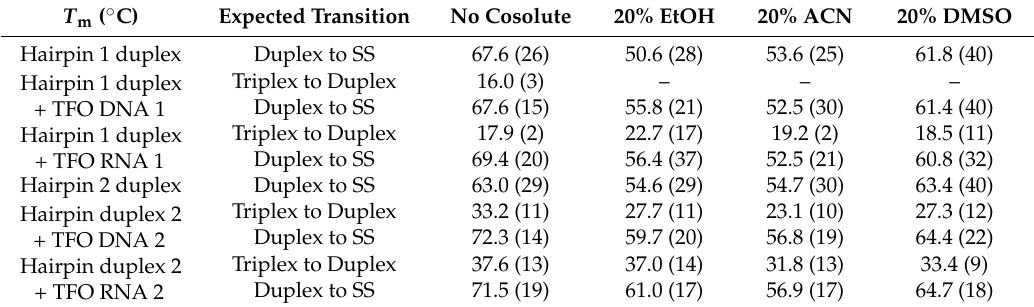
Table 2. Melting temperatures ( T m , ˝ C) calculated from thermal denaturation curves of hairpin duplex and the expected triplexes formed with hairpin and DNA- or RNA-triplex forming oligonucleotides (TFO) a